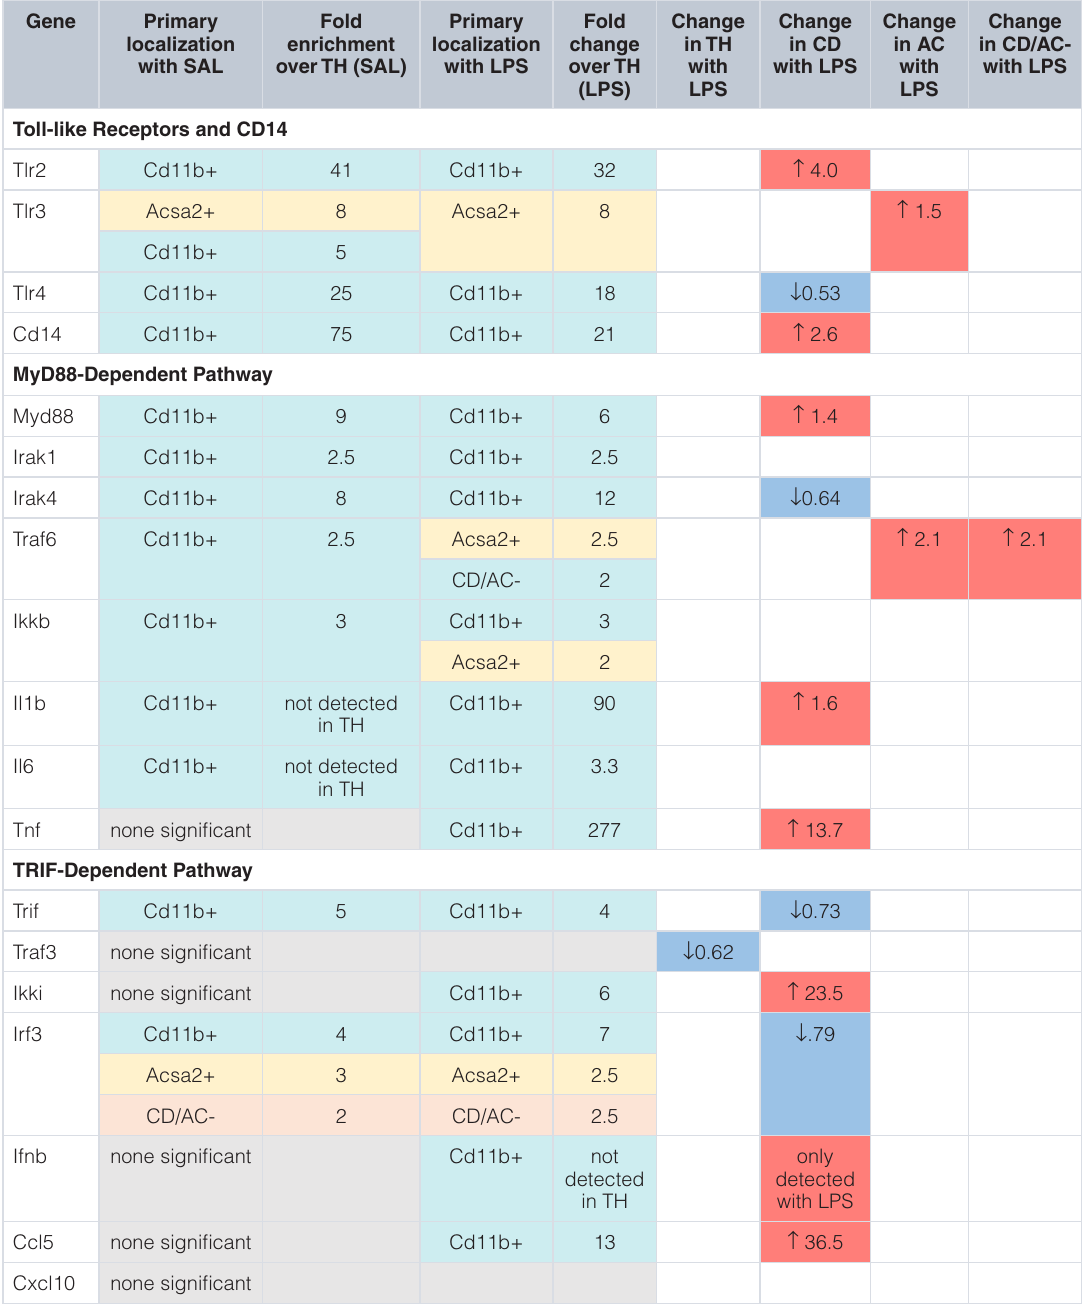
Table 1. Summary of qPCR data. Summary of 24 hour LPS qPCR data. Colors indicate fraction: microglial, teal; astrocyte, yellow; negative fraction, orange. Primary localization with saline (SAL) is determined by fraction enrichment compared to the total homogenate (TH) under saline conditions, with fold-enrichment shown in the next column. Primary localization with liposaccharide (LPS) is determined by fraction enrichment compared to the TH with LPS treatment, with fold change shown in the next column. Change in each fraction with LPS is determined by comparing expression in that fraction with SAL to expression in that fraction with LPS, with direction and fold-change noted. Red indicates increased expression, while blue indicates decreased expression. Only significant differences are noted (p<0.05, two-way ANOVA with Tukey’s multiple comparisons test). CD, Cd11b+; AC,